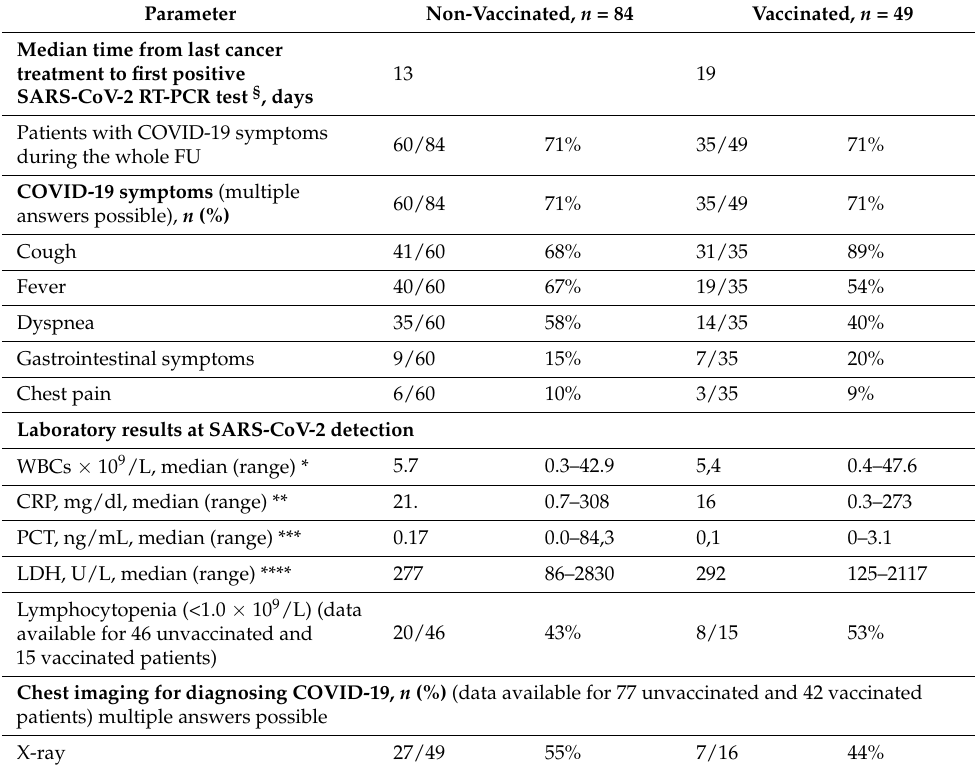
Patients with COVID-19 symptoms during the whole FU COVID-19 symptoms (multiple answers possible), n